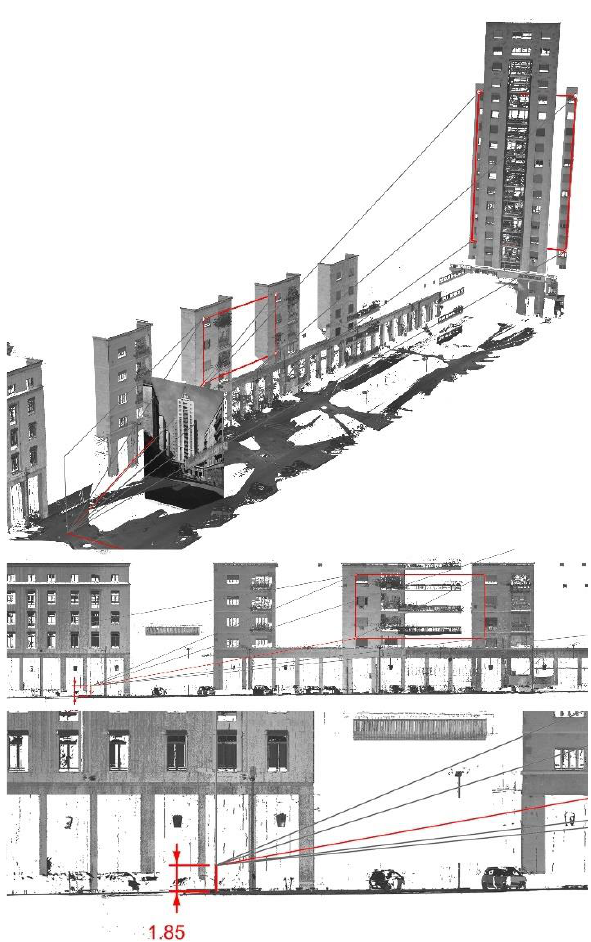
Figure 9: External orientation of Alinari’s image and comparison between restituted and real rectangles; the position of the point of view results acceptable.